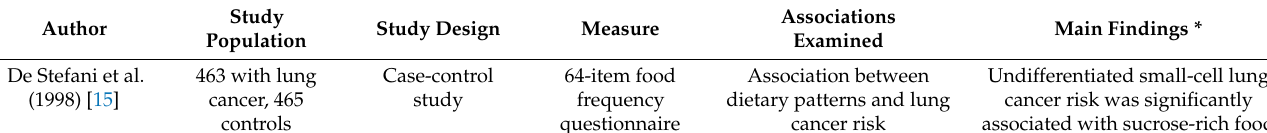
Table 4. Added sugar intake and risk of developing cancers and mortality (mixed